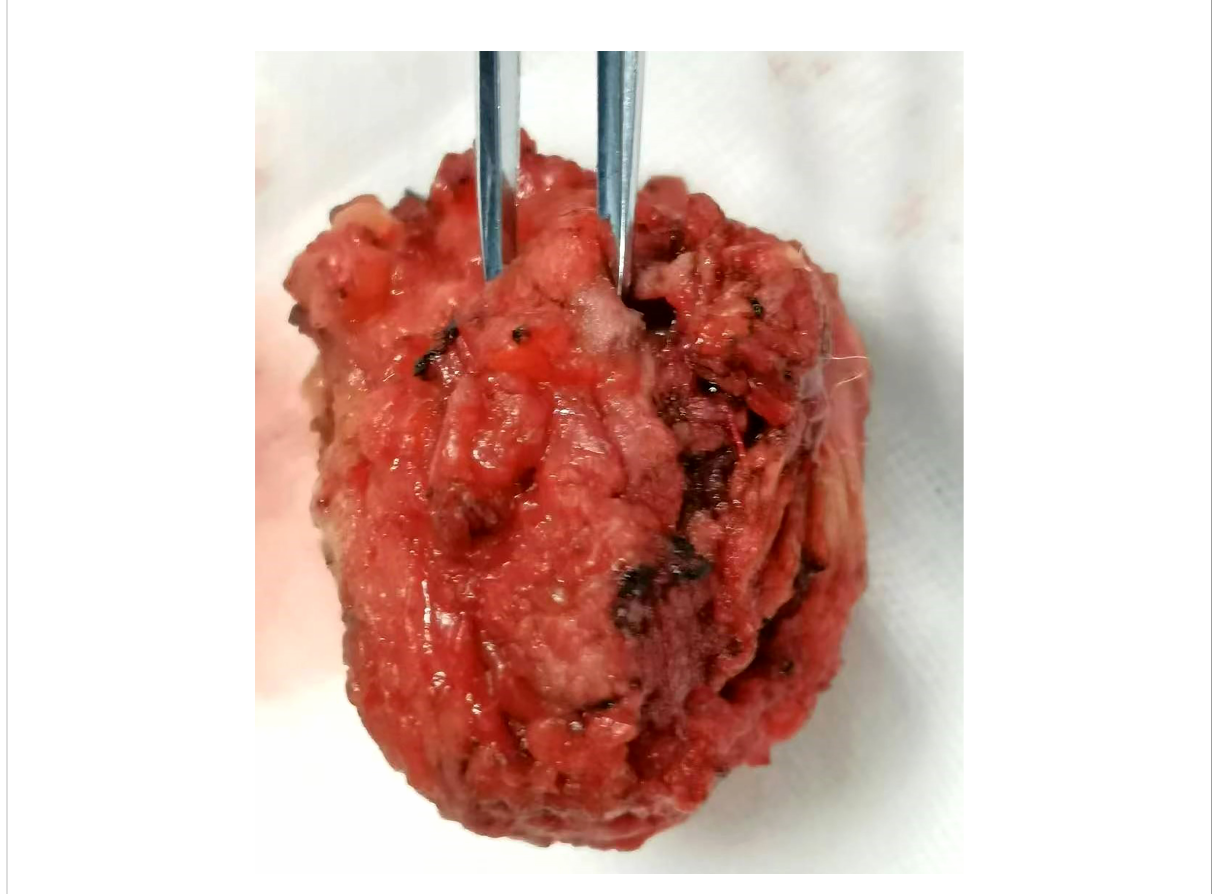
FIGURE 2 Resected lump specimens (4 cm × 3